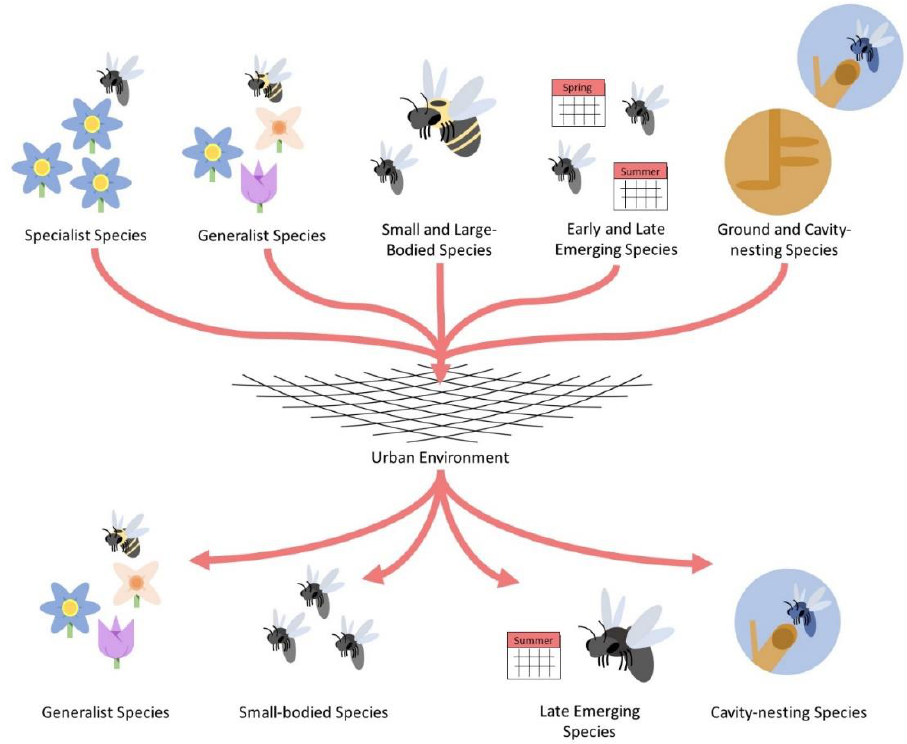
Figure 2. Simplistic diagram depicting the filtering of some functional traits comprising urban bee communities. The “net” in the center of the diagram represents a generic urban environment with all its associated local and landscape features that may influence bee community structure. General bee functional traits are presented at the top of the figure whereas traits selectively favored by cities are presented at the bottom.